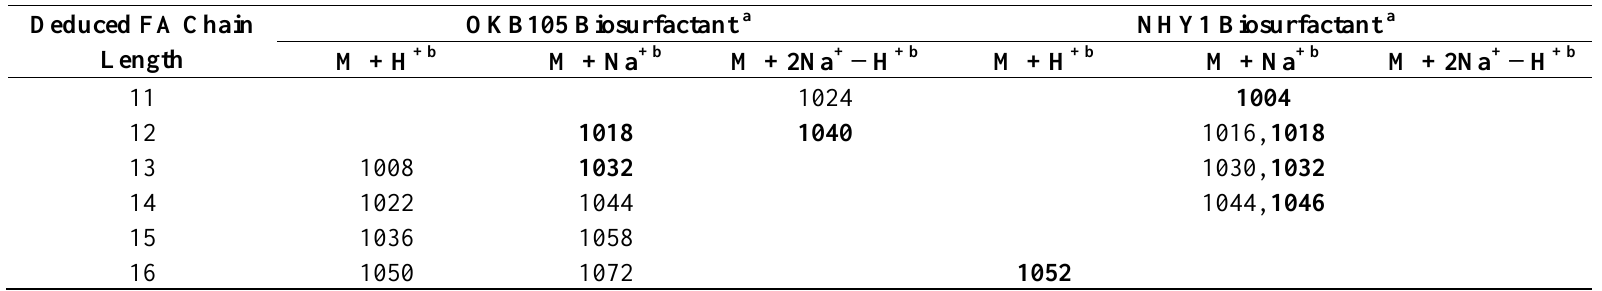
Table 3. Molecular weights of OKB105 and NHY1 biosurfactants determined by electrospray ionization mass